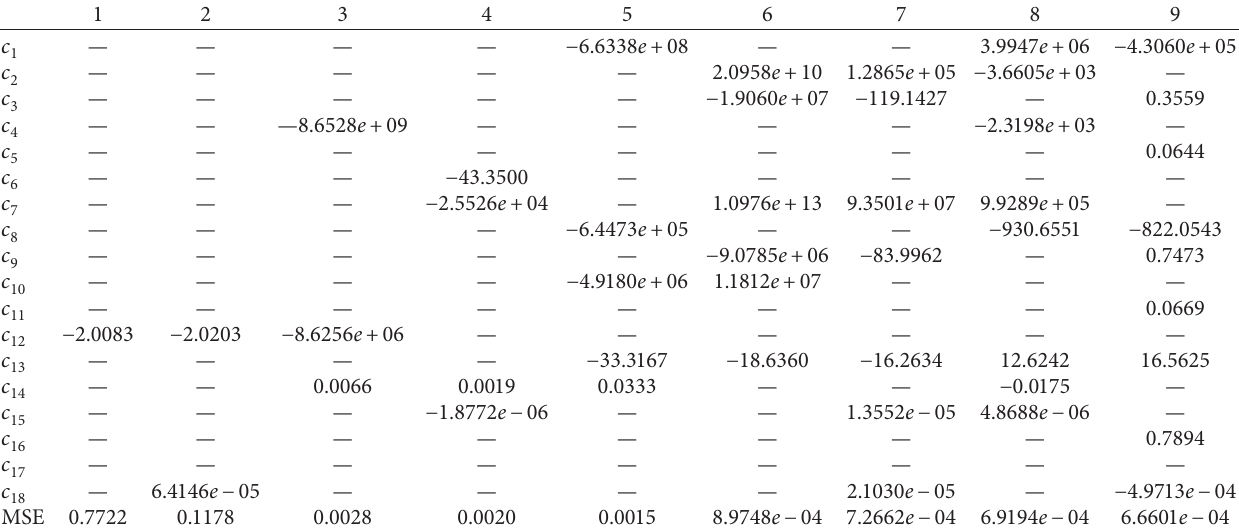
Table 5: Smallest MSE value for tested model coefficient counts 1–9 for f